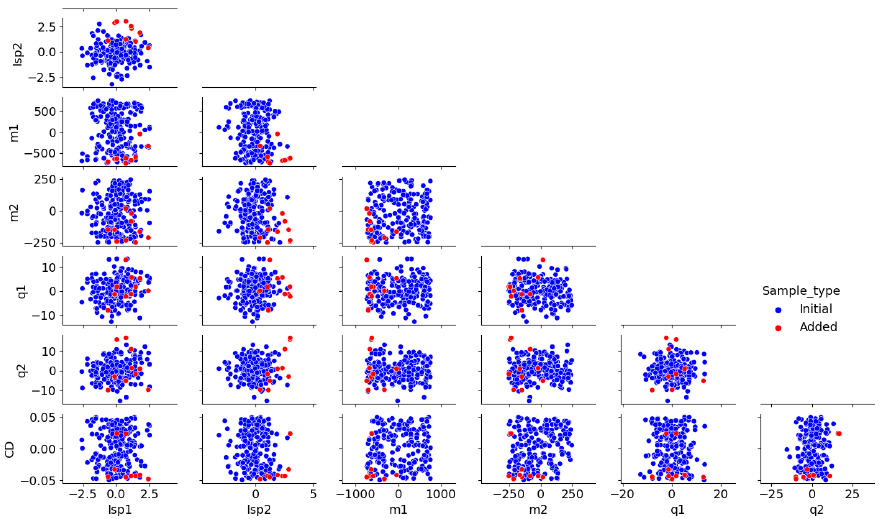
Figure 17. Pairplot of the initial and added samples for the input uncertain variables.